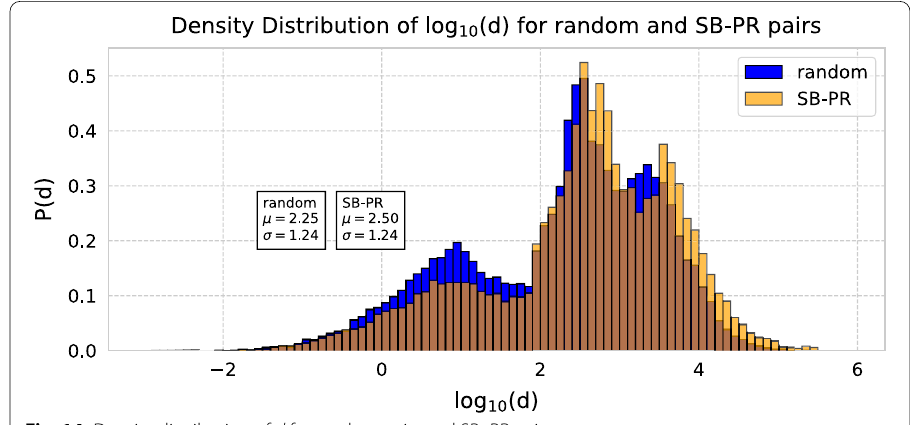
Fig. 14 Density distribution of d for random pairs and SB–PR pairs